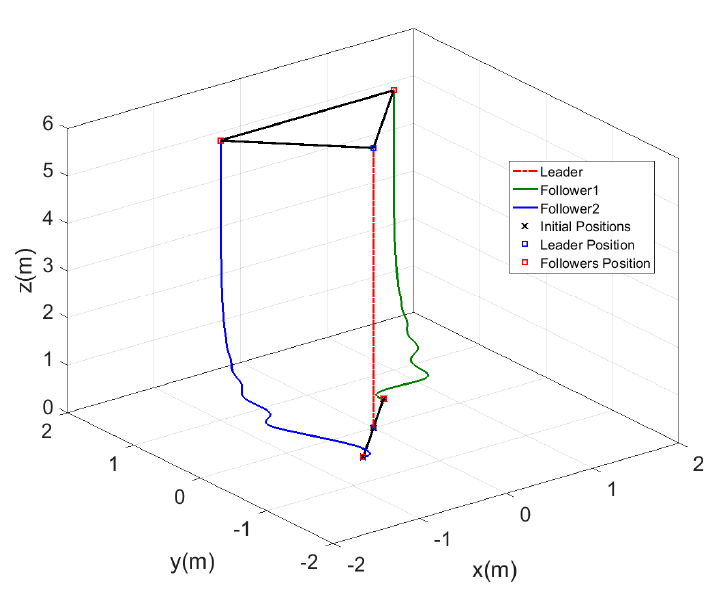
Figure 13. Three dimensional view of fixed triangle formation for MAS.